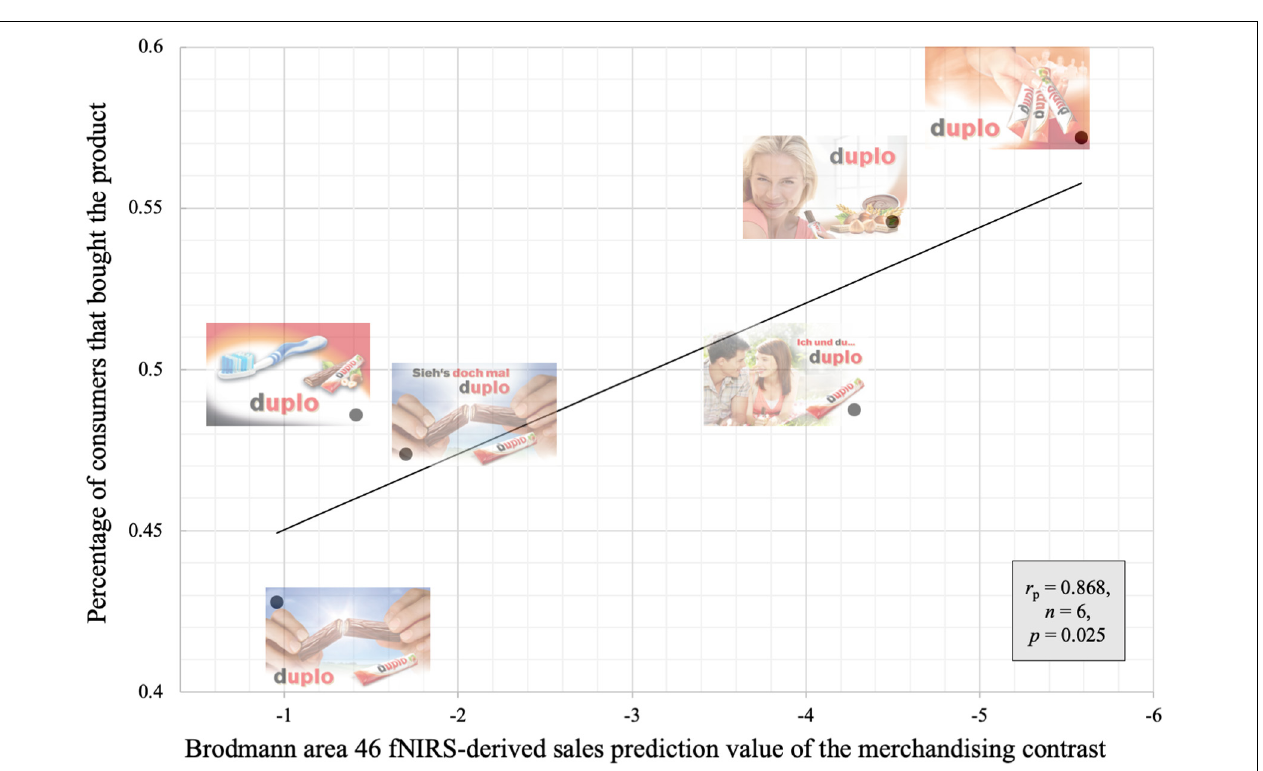
FIGURE 6 | Scatterplot depicting the association between the Brodmann area 46 fNIRS-derived sales prediction value of the merchandising contrast, and actual product sales (Kühn et al., 2016) expressed in percentage of the customers that bought the product on the display with the merchandising element. Pearson correlation presented in the grey